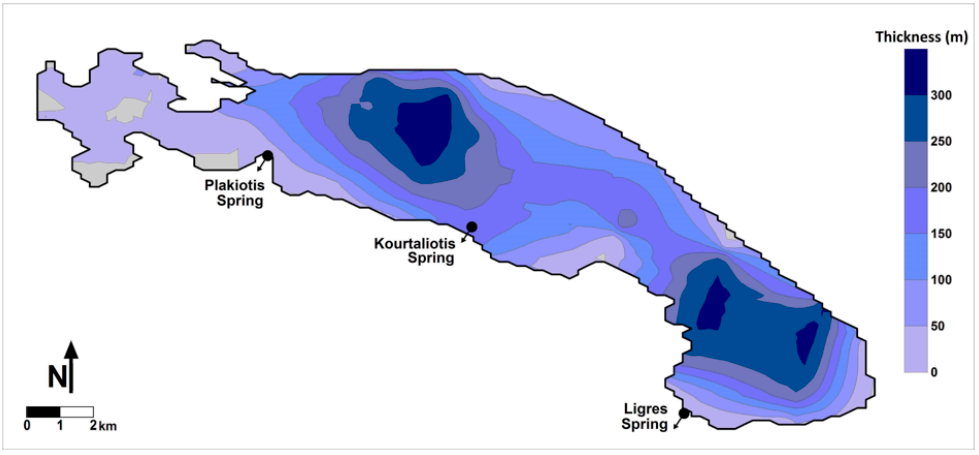
Figure 5. Thickness of the carbonate formations in the hydrogeological basin. The contours represent the combined thicknesses of Tripolis and Pindos carbonate formations.